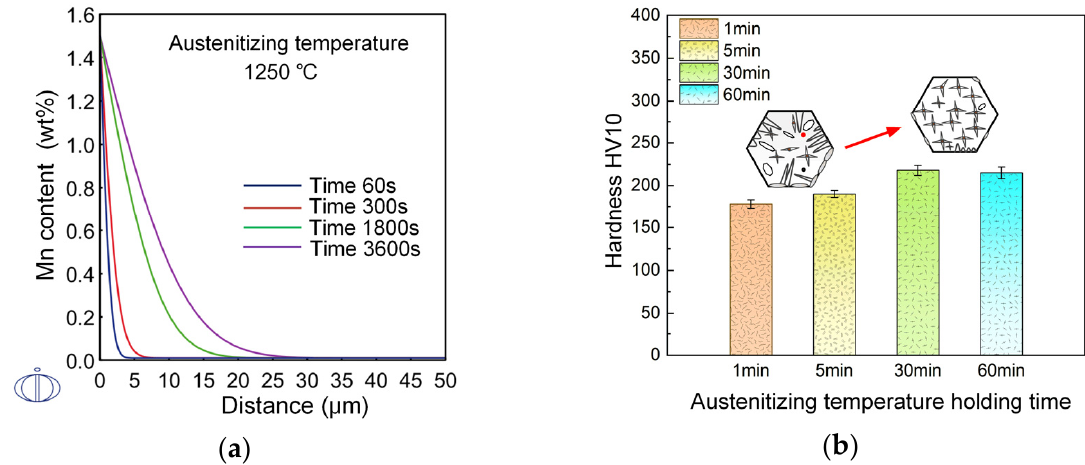
Figure 10. ( a ) Mn diffusion distance and ( b ) macro-hardness of steel samples with different hold times at 1250